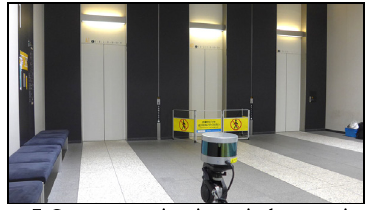
Figure 7. Laser scanning in an indoor